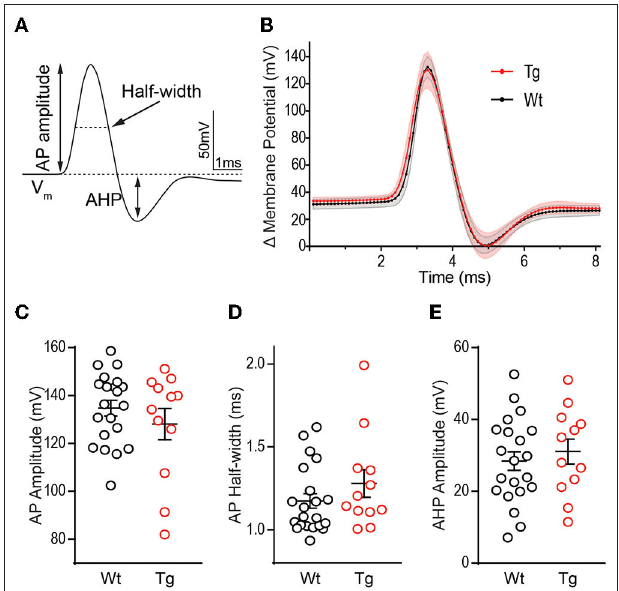
FIGURE 3 | Action potential waveform properties are not different between TgF344-AD and wild-type (Wt) DGCs. (A) Schematic of measurements derived from a typical action potential waveform, including, AP amplitude, half-width, and after hyperpolarization (AHP). (B) Averages of the first action potential fired at rheobase in each genotype (error bars represent scanning electron microscope (SEM)). (C) Action potential height (mV), (D) action potential half-width (ms), and (E) AHP amplitude (mV) in DGCs from 6 month TgF344-AD and Wt female rats are not different. For all panels, Wt, n = 22 cells/8 animals, Tg, n = 13 cells/6 animals, p > 0.05. Data represent mean ± SEM. Significance is determined using the unpaired Student’s t -test.